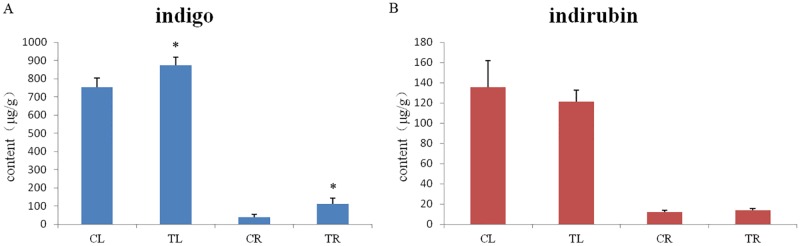
Contents of indigo and indirubin in leaf and root of B.cusia.(A) content of indigo; (B) content of indirubin.